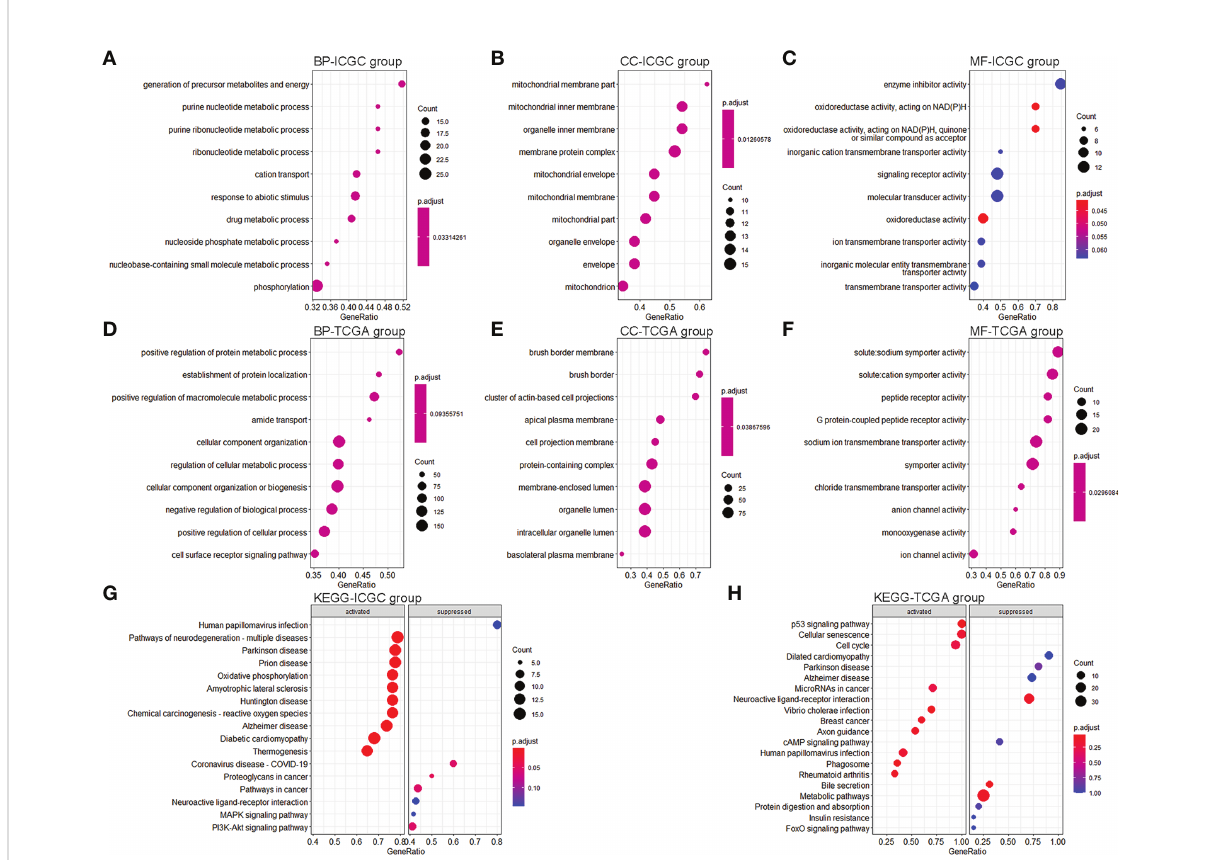
FIGURE 6 GO and KEGG pathway enrichment analyses. (A – C) Top 10 enrichment BP (A) , CC (B) , and MF (C) between KC patients with a high-risk value and low-risk value in the training group. (D – F) Top 10 enrichment BP (D) , CC (E) , and MF (F) between KC patients with a high-risk value and low-risk value in the validation group. (G) Top 10 enrichment KEGG between KC patients with a high-risk value and low-risk value in the training group. (H) Top 10 enrichment KEGG between KC patients with a high-risk value and low-risk value in the validation